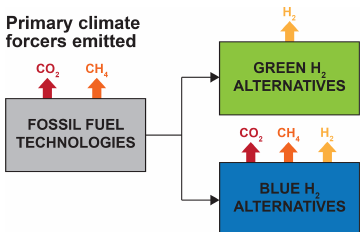
Figure 2. Primary climate forcers emitted from fossil fuel technolo- gies and their clean hydrogen